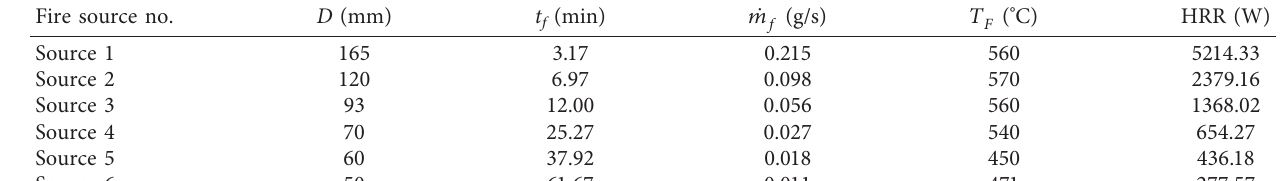
Table 4: Summary table of the results deduced from the free tests.